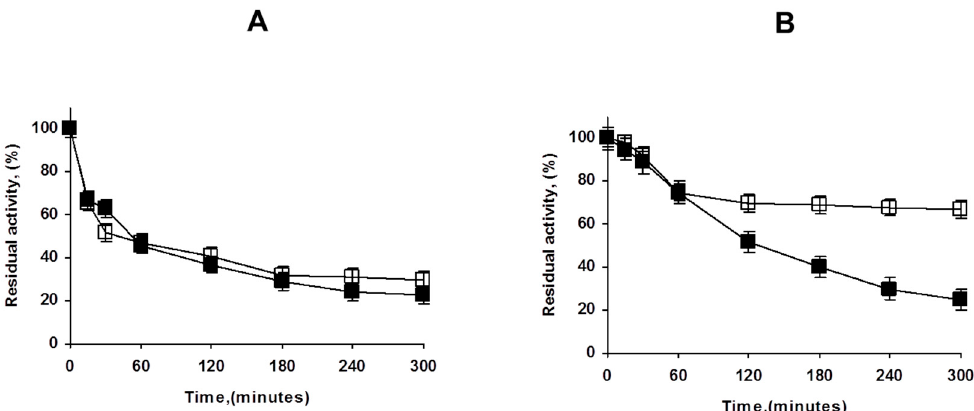
Figure 7. Effect of glutaraldehyde modification of OA-PFL-PEI biocatalysts preparations at different enzyme loadings ( A : lowly loaded, B : highly loaded). Inactivation was carried out in 50 mM Tris at pH 7 and 75 °C as described in Methods. Solid symbols: PEI coated octyl-PFL; Hollow symbols: Glutaraldehyde modified biocatalysts.